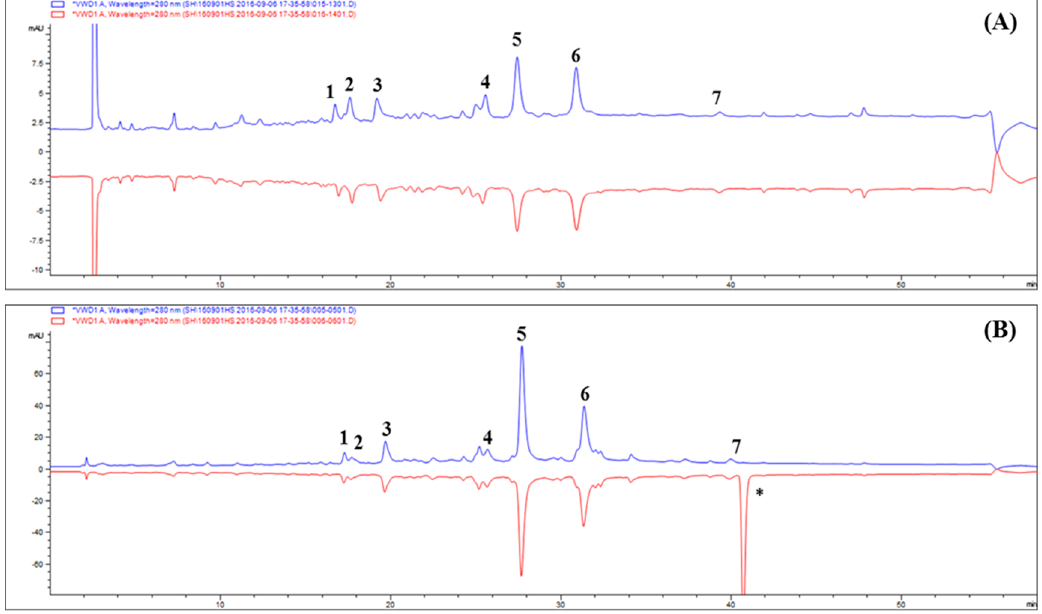
Figure 2. Screening of aldose reductase and antioxidant inhibitors in Tanacetum parthenium L. using by ultrafiltration of HRAR ( A ) and DPPH-HPLC ( B ) at 254 nm. Blue line: before reaction without HRAR and DPPH; red line: after reaction with HRAR and DPPH, respectively.